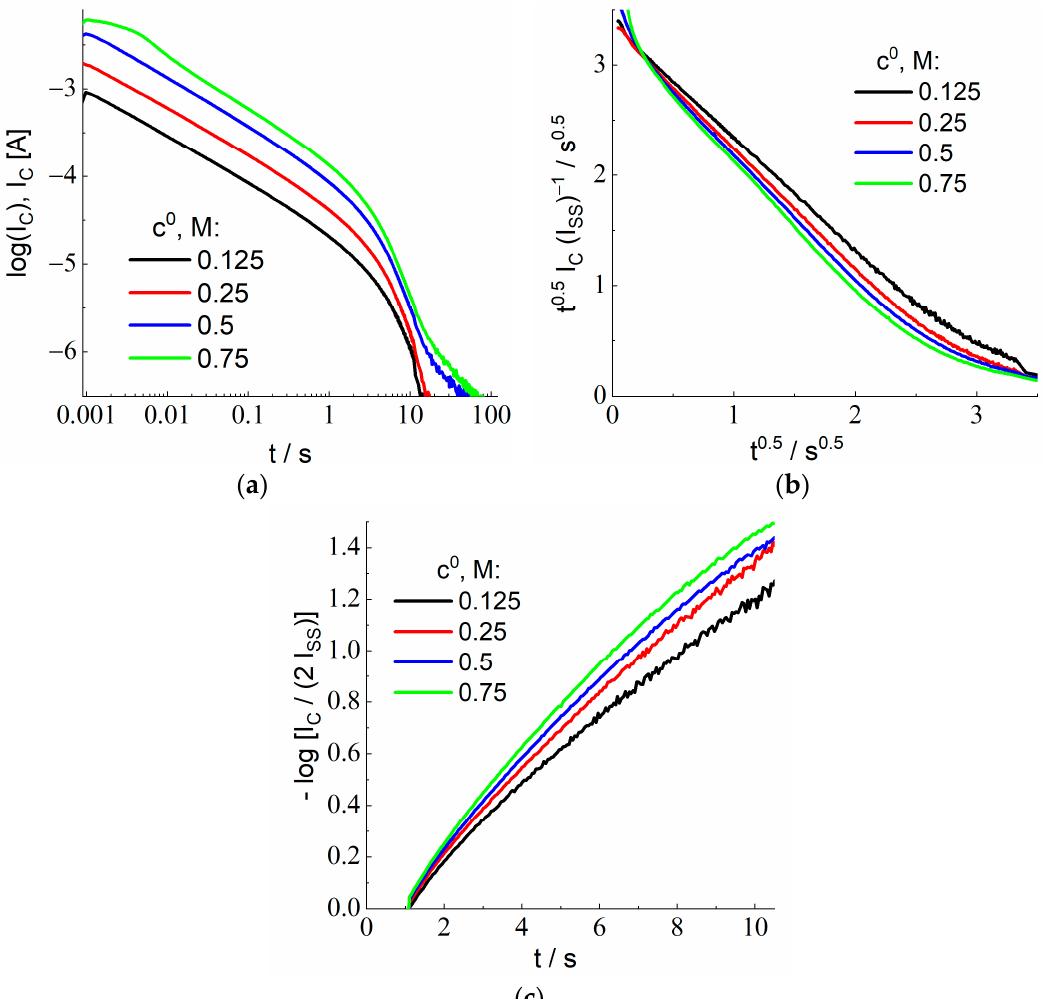
Figure 5. ( a ) Current transients after the backward potential step (from 1.0 to 0.4 V) for the Pt electrode (diameter: 1 mm) coated with the Nafion 212 membrane in contact with 2 M sulfuric acid with the addition of various HBr amounts, c 0 , from 0.125 to 0.75 M (its values are indicated in the figure) in the bilogarithmic (decimal logarithms) coordinates. ( b ) Experimental data of ( a ) within the short-time range recalculated with the use of the coordinates: t 1/2 I C /I ss vs t 1/2 , where the theory, Equation (32), predicts a linear dependence with the slope equal to − 1 and with the intercept of the Y-axis equal to L/( π D C ) 1/2 . ( c ) Experimental data of ( a ) within the extended-time range recalculated with the use